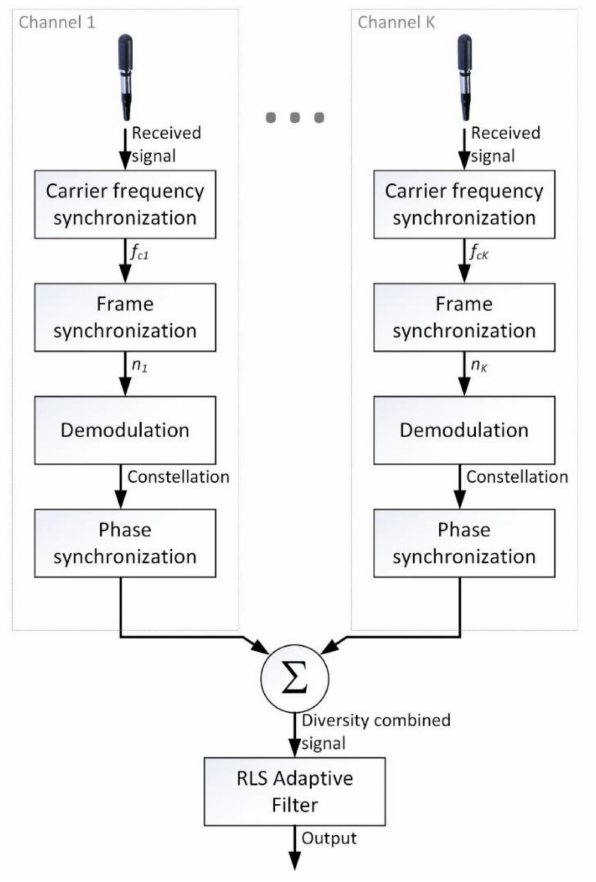
Figure 1. Block diagram of the